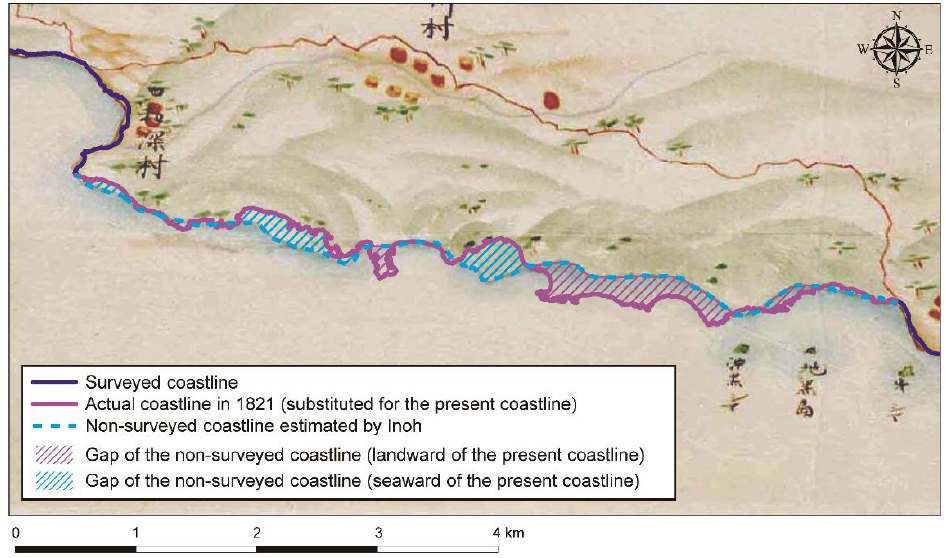
Figure 6. Gap between the non-surveyed (estimated) coastline and the actual coastline. Source: Digital Inoh ’ s Map and GSI map.